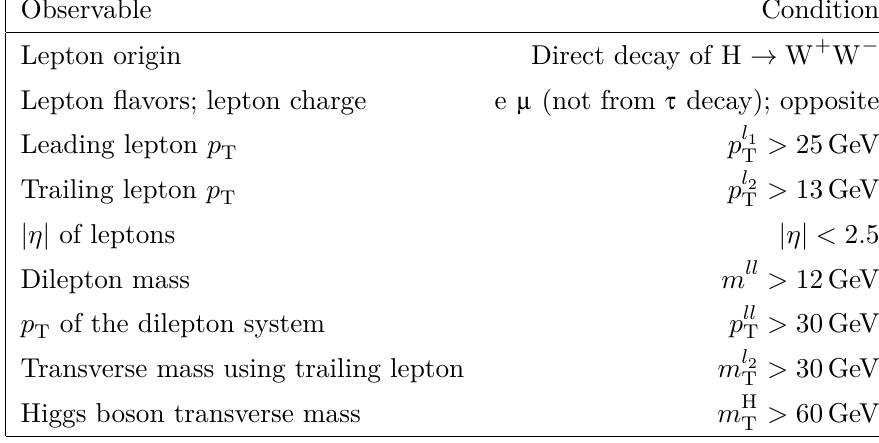
Table 1 . Definition of the fiducial